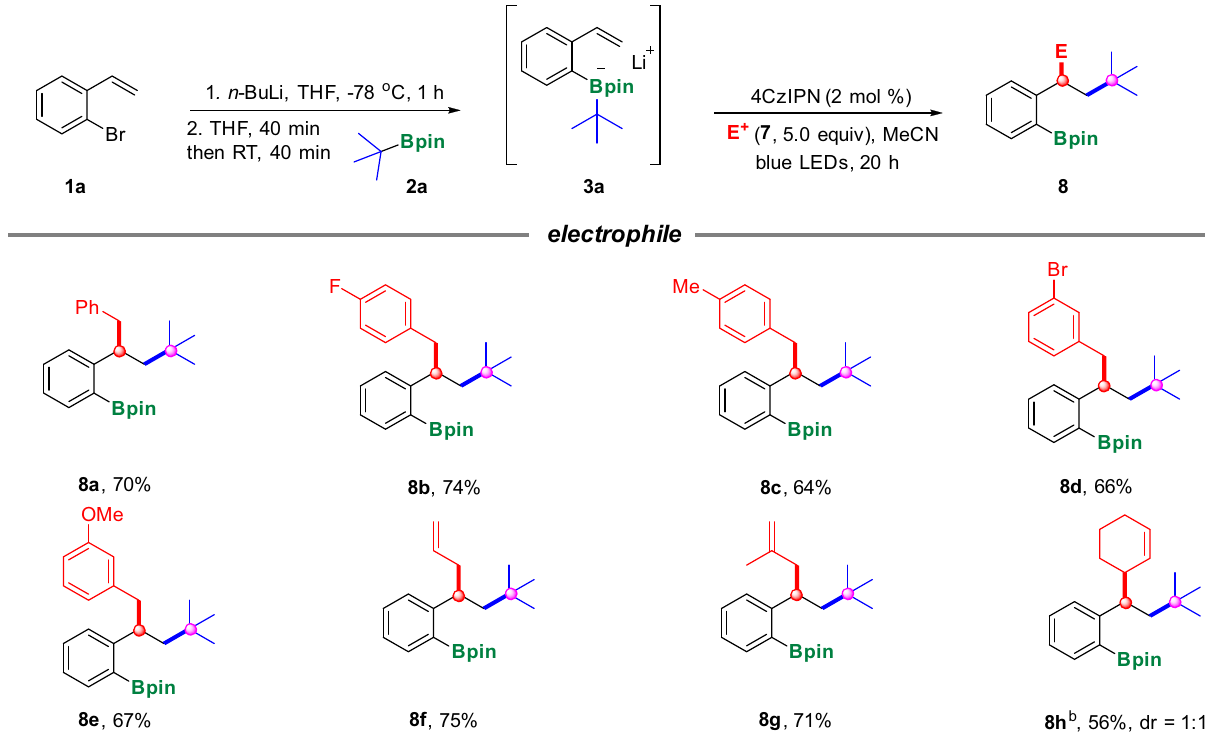
Fig. 4 Scope of electrophiles. [a] Reaction conditions: To a solution of o -bromostyrene 1a (0.26 mmol, 1.3 equiv) in THF (0.6 mL) was added n- BuLi (0.26 mmol, 1.3 equiv) − 78 °C under argon, the resulting mixture was stirred at − 78 °C for 1 h, then 2a (0.2 mmol, 1.0 equiv) in THF (0.2 mL) was added and stirred at − 78 °C for 40 min and warm to room temperature for 40 min; then electrophile 7 (1.0 mmol, 5.0 equiv) and 4CzIPN (2 mol%) were added in MeCN (2 mL, 0.1 M) and irradiated by blue LEDs under an argon atmosphere for 20 h; [b] The dr was determined by 1 H NMR